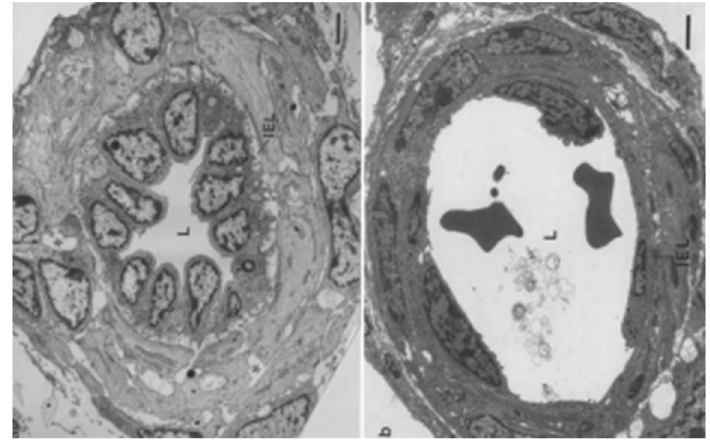
Figure 3. Electron micrographs of transverse sections through small muscular lung arterioles in naturally born piglets in a stillborn on the left and at 5 min of life taken at the same magnification. At birth, the endothelial cells of the intra-acinar arteries showed more rapid and greater changes in shape and thickness than did the cells of more proximal vessels. IEL: internal elastic lamina; L: lumen. Scale bar line on lower right = 2 μ m. Adapted from Haworth et al. [27] (with permission).